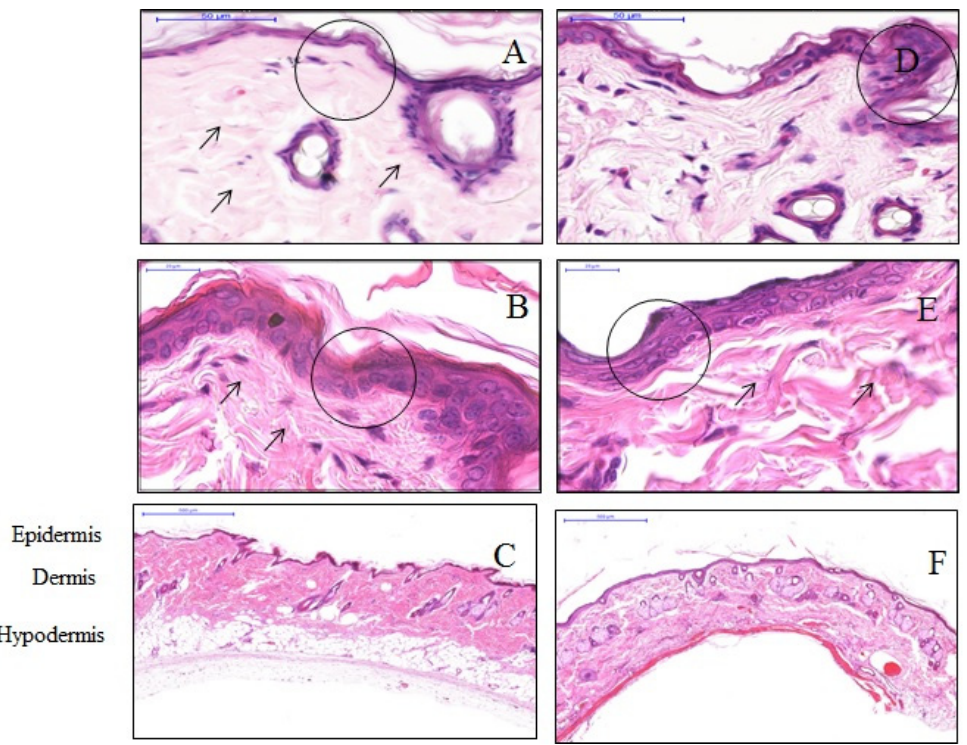
Figure 1. Histology of the epidermis. Representative images of control ( A – C ) and expanded